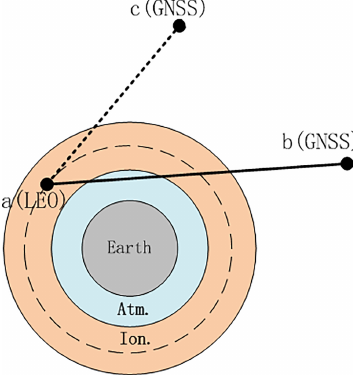
Figure 2. Schematic geometry of GNSS radio occultation for sin- gle differencing (using link a - c in addition to link a - b ) and zero differencing (using link a - b